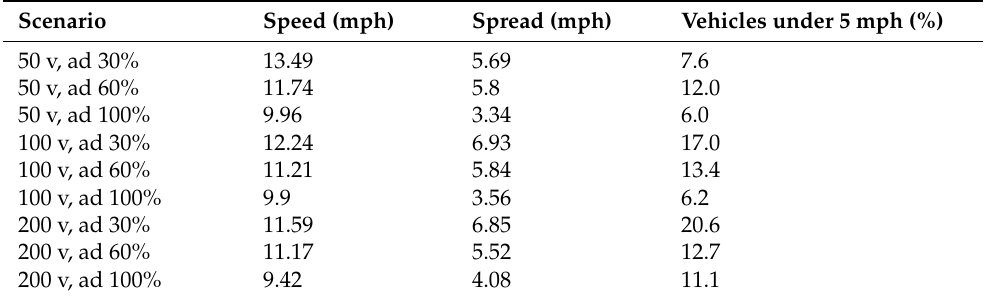
Table 4. Average speed, spread of speeds, and fraction of vehicles moving below 5 mph for each scenario (where v = vehicles and ad = adherence percentage). Scenario Speed (mph) Spread